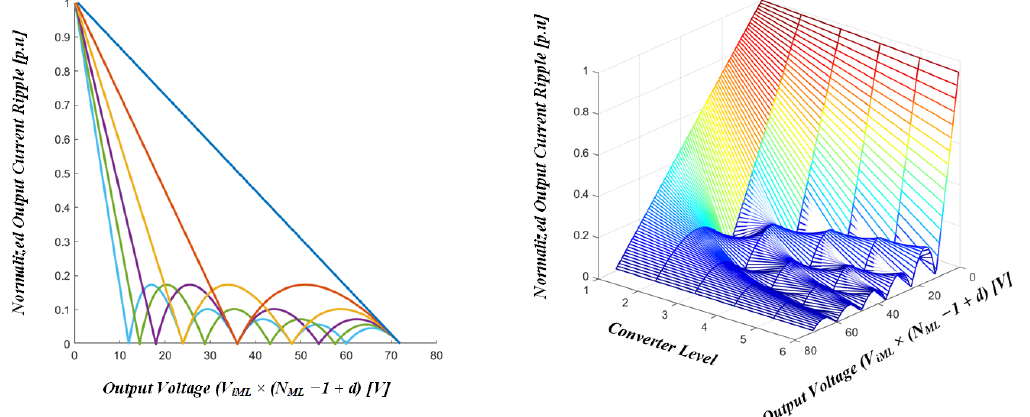
Figure 7. Normalized output current ripple versus duty cycle.